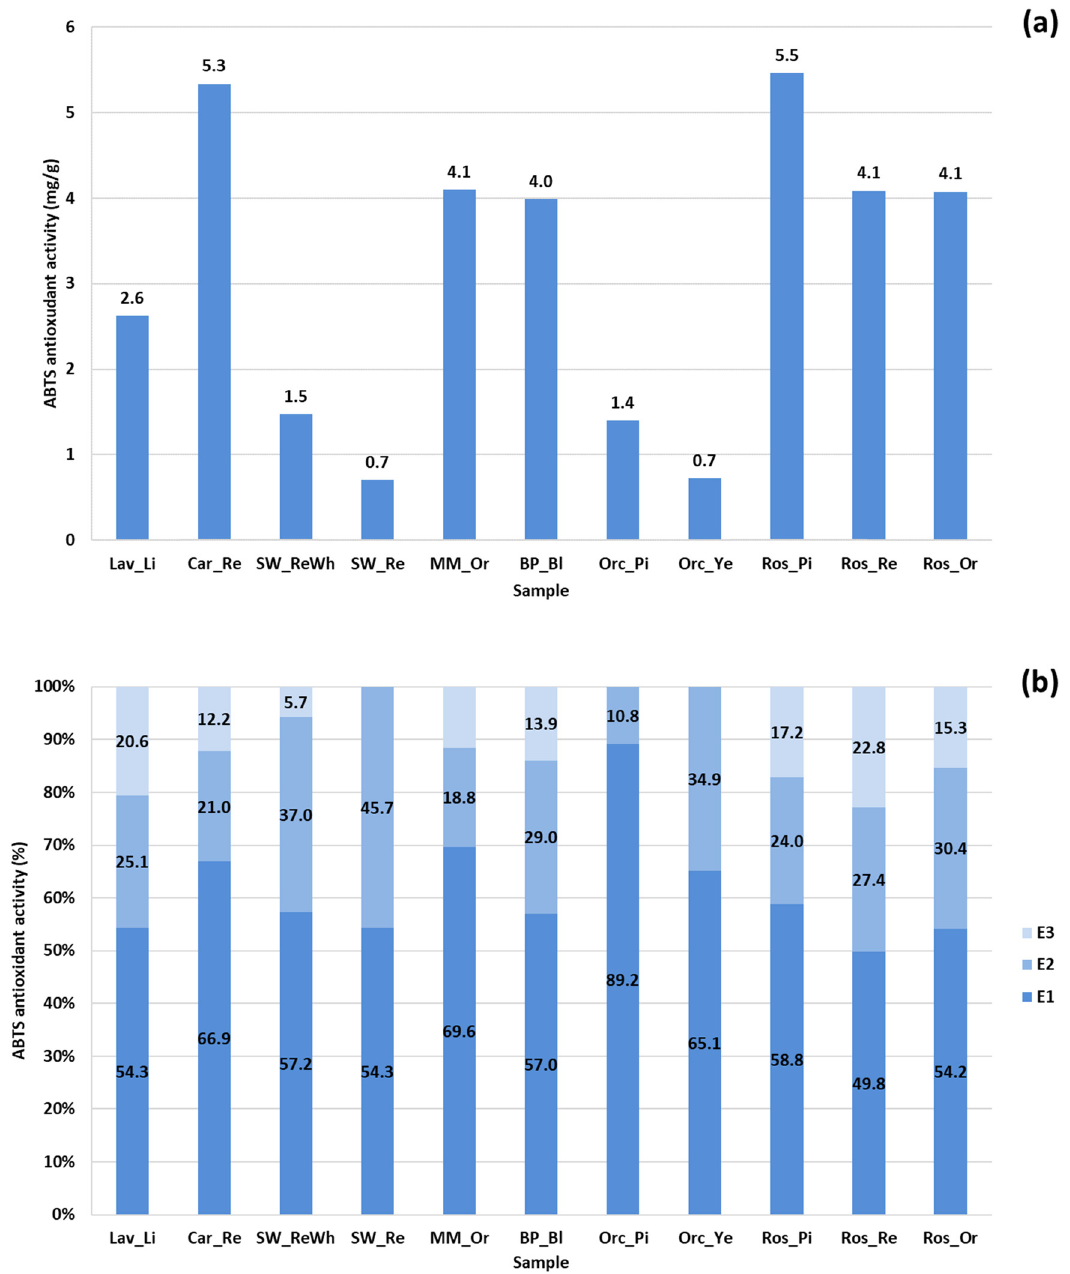
Figure 7: ABTS AOA in the fi rst extraction ( a ) and relative percentage of three extractions ( b )